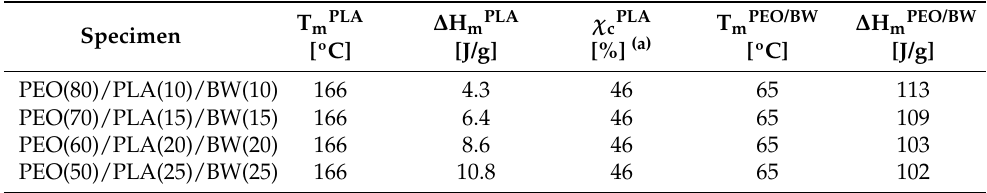
Table 2. Melting temperature and enthalpy of PLA and PEO/BW, registered by DSC. PLA crystallinity degree in the composite fibrous materials.